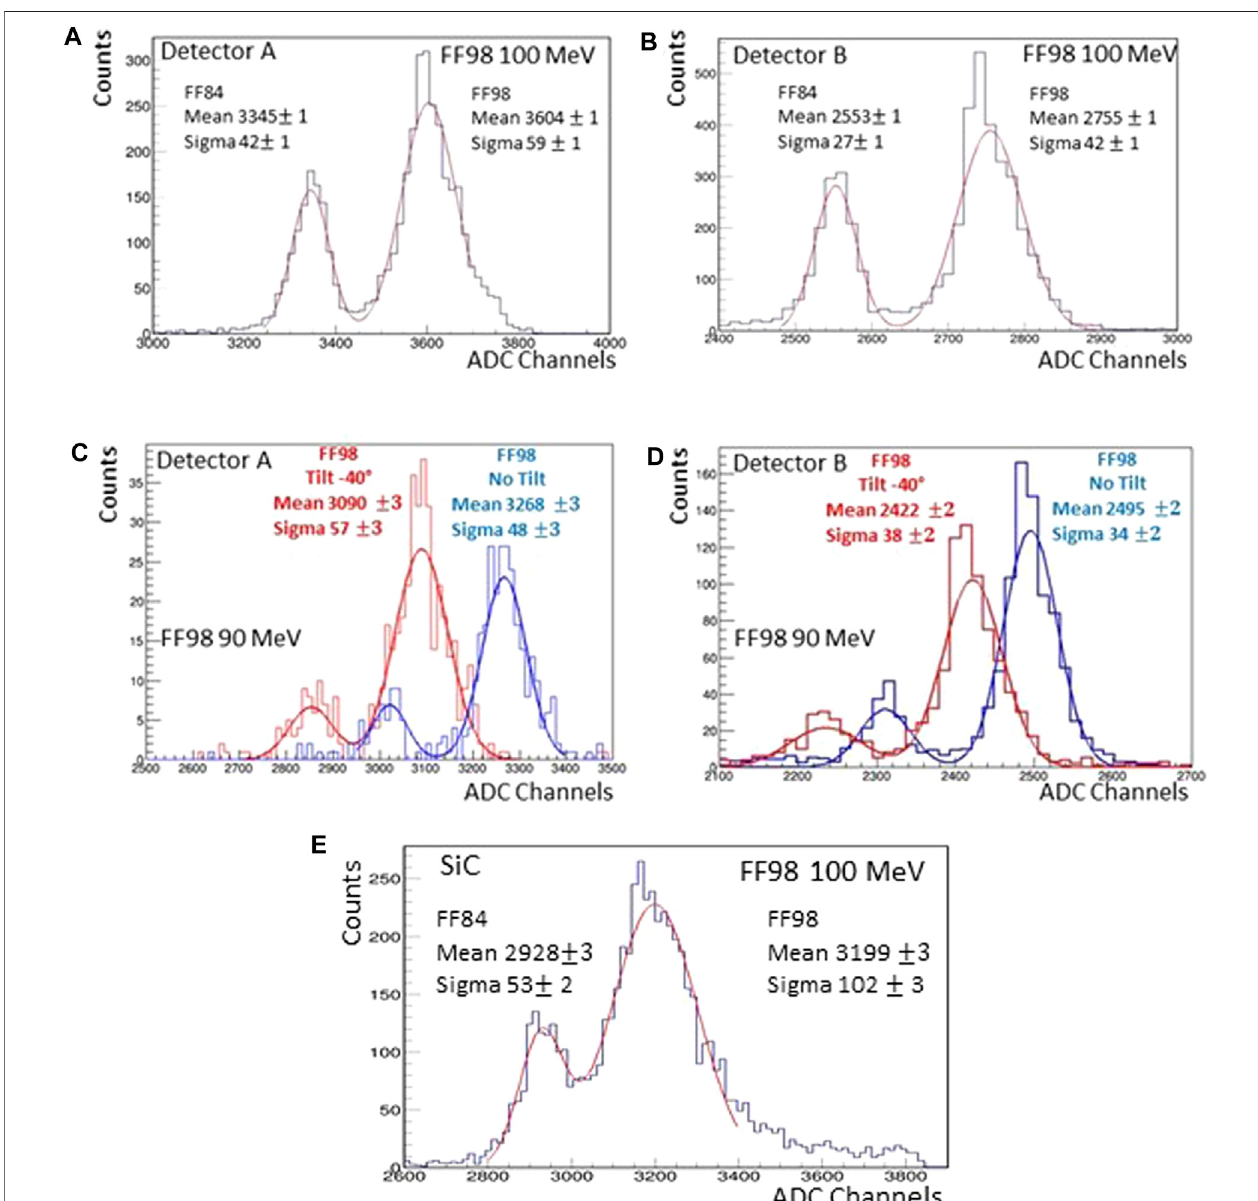
FIGURE 8 | FF98 and FF84 spectroscopic measurement and energy resolution with diamond detectors A (A) and B (B) for energy of 100 MeV for FF98 and 86 MeV for FF84. The diamond A is biased at -450 V, the diamond B at -200 V, and for both side 0 ° is exposed to FF. Tilt of the diamond detector A (C) and diamond detector B (D) for 90 MeV FF98, the blue curve corresponds to 0 ° , the red one to a tilt of − 40 ° . The ratio of the two mean values is 94.6% (diamond A) and 97.0% (diamond B), i.e. the pulse height defect increases by 5.4% for diamond A and 3% for diamond B. The FF98 and FF84 spectroscopic measurement and energy resolution with the SiC detector are illustrated in (E) . It is biased at -100